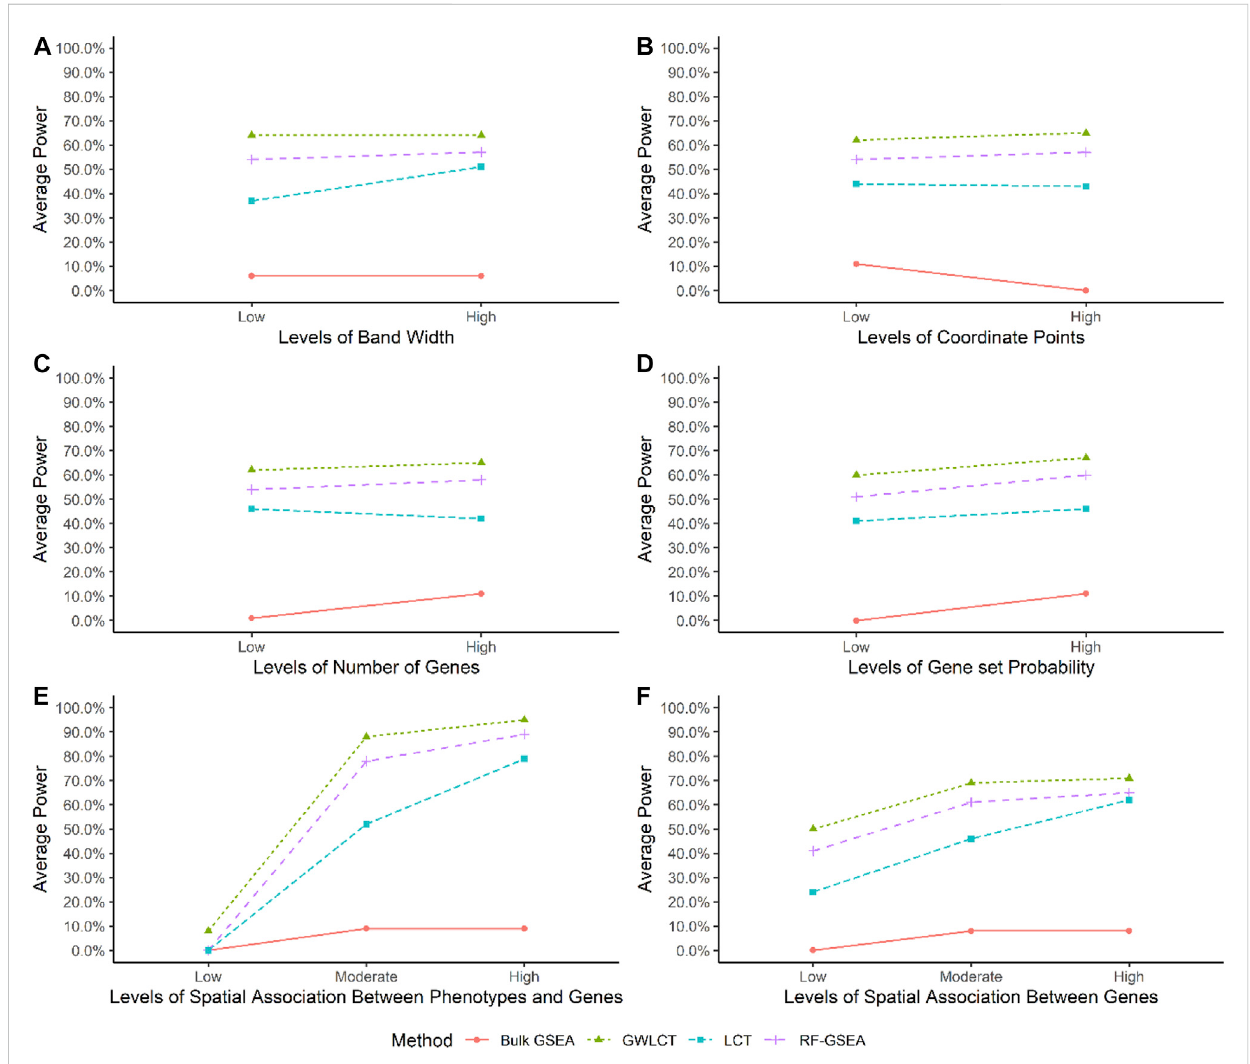
FIGURE 6 Comparing the average statistical power of each method across various levels of simulation parameters. Considering GWLCT as the reference category and using Dunnett ’ s test, we compared the average power of GWLCT (green) against Bulk GSEA (red), LCT (blue) and RF-GSEA (purple) by varying from Low to Moderate to High levels of the following parameters: (A) the kernel bandwidth, (B) the number of coordinate points, (C) the number of genes, (D) gene-set probability (size of gene-sets), (E) the spatial association between genes and continuous phenotype, and (F) the spatial association between genes. For detailed interpretation of the results in terms of the testing signi fi cance given by the p -values, see